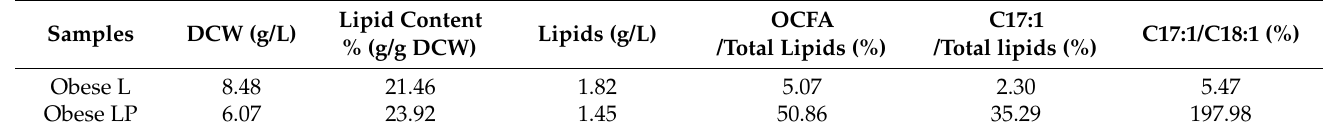
Table 1. Biomass and lipid content from obese L and obese LP strains. The samples harvested at 216 h were used for the analysis of